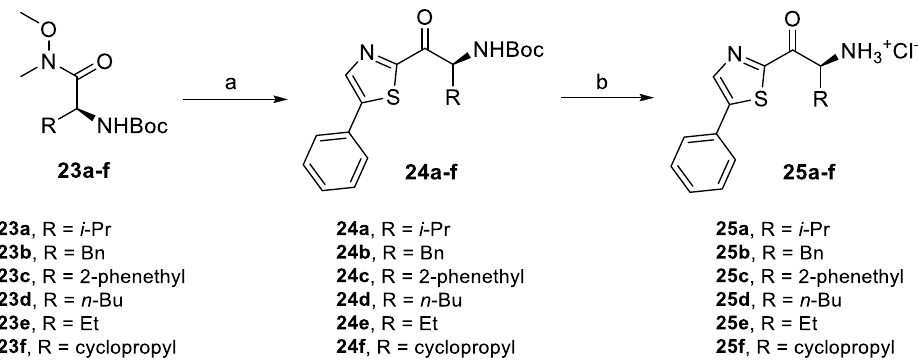
Figure 8. Synthesis of thiazole derivatives with variation of the alkyl chain. Reagents and conditions: (a) (i) 5-phenylthiazole ( 22 ), n -BuLi, THF, -78 °C, (ii) 23a – f , n -BuLi, -78 °C, 67 – 78%, and (b) AcCl, MeOH, r.t., 69 – 93%.